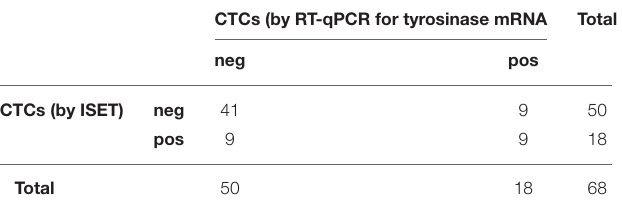
TABLE 6 | Number of positive cases per class of melanoma patients obtained by assessing RASSF1A methylated cfDNA, the presence of CTCs by either method, and by combining the determination of the circulating methylated RASSF1A marker with the detection of